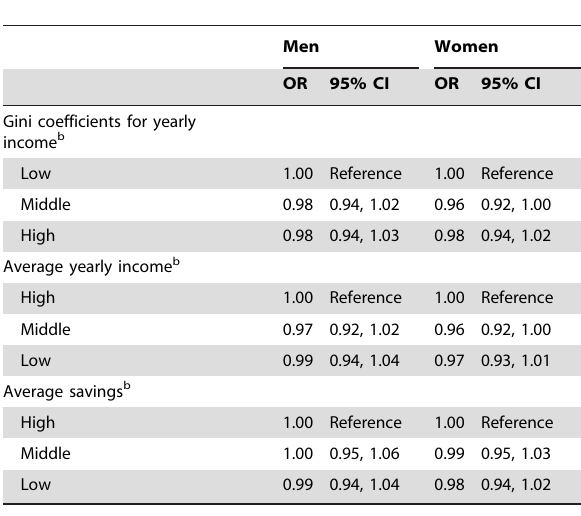
Table 2. Odds ratios for all-cause mortality associated with prefecture-level socioeconomic status variables, Japan, 2005 a